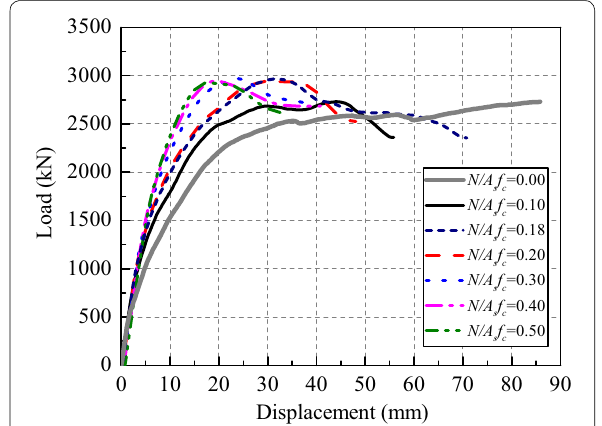
Fig. 26 Effect of the axial compression